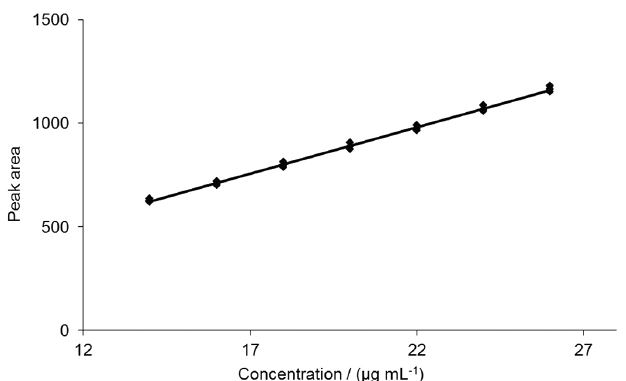
FIGURE 2 - Analytical curve obtained in linearity TABLE III - Regression parameters of analytical curve Regression parameters